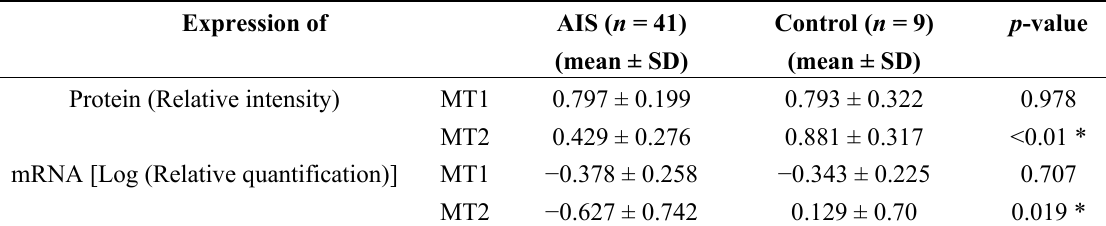
Table 1. Expression of melatonin receptor MT1 and MT2 in osteoblasts. The protein and mRNA expression levels of melatonin receptor MT1 and MT2 between AIS and control were compared by Student’s t -test, * p < 0.05. All data were expressed as the mean ± SD. The protein level was expressed in relative intensity after correction by beta-actin. Expression of AIS ( n = 41) p -value (mean ± SD) (mean ± SD) Protein (Relative intensity)